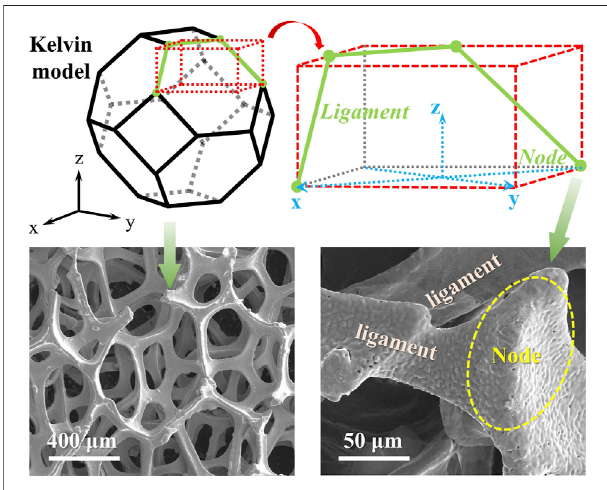
FIGURE 2 | Schematic of Kelvin model and its structural correspondence to the G-Cu f